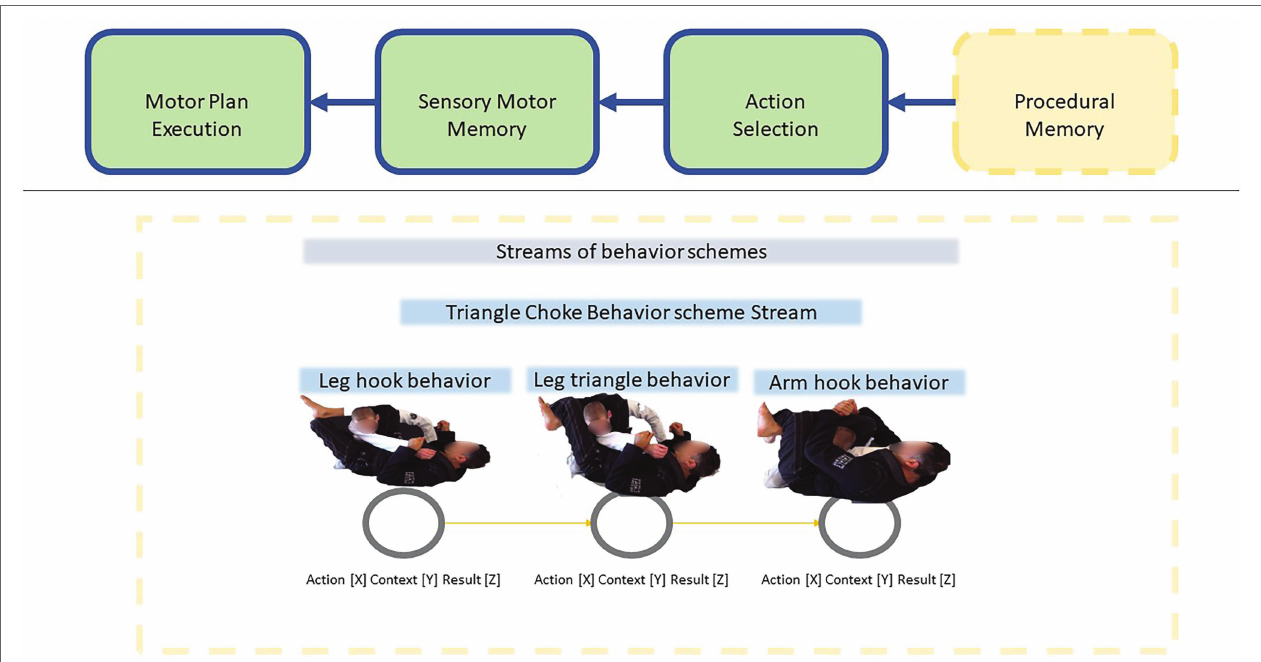
FIGURE 4 | Procedural Memory contains streams of specialized behaviors. For example, to perform the Triangle Choke from Brazilian jiu jitsu the agent must first hook their leg around the opponent, form a leg triangle, and then tighten the triangle with legs and arm. These separate behaviors can be executed fluently by having each action linked together in a behavior stream that can have its variables specified with data from the conscious broadcast. By learning actions that are chained together, agents can execute highly specialized